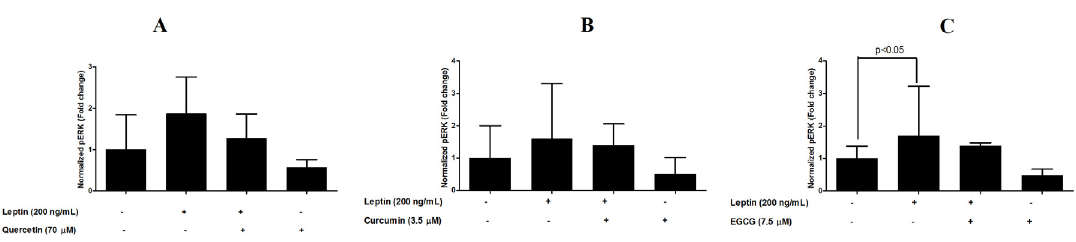
Figure 4. Leptin-induced ERK1/2 phosphorylation in ( A ) quercetin ( B ) curcumin and ( C ) EGCG in MCF-7 breast cancer cells.